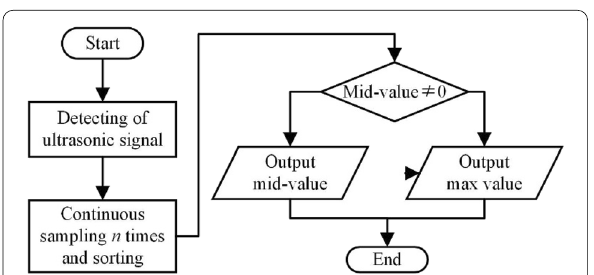
Figure 5 Filtering process of the ultrasonic signal